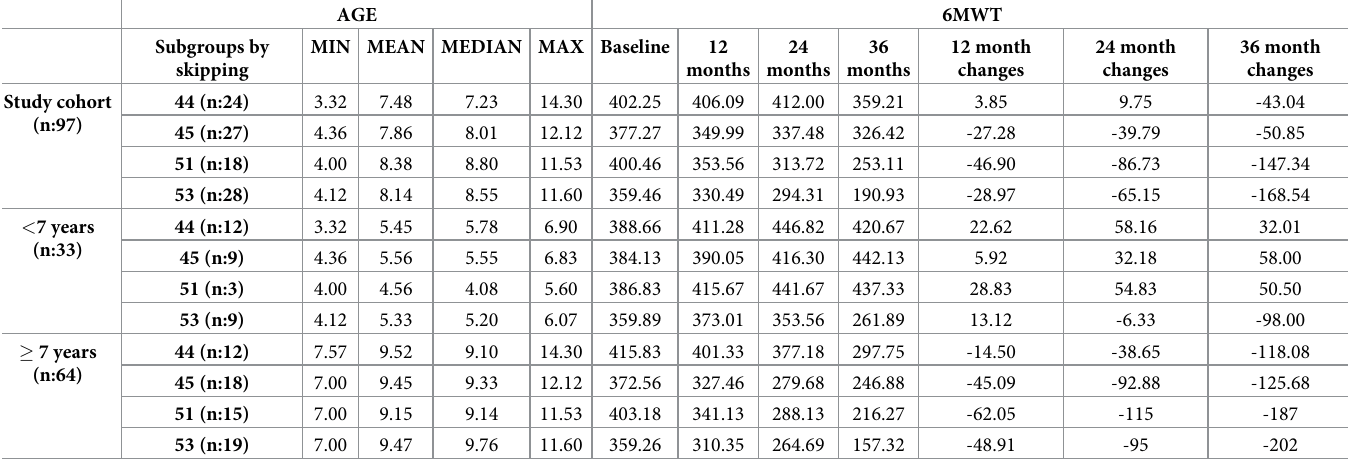
Table 3. Baseline 12, 24, 36 month 6MWT values (range, mean and median) subdivided according to genotype and age. AGE 6MWT Subgroups by